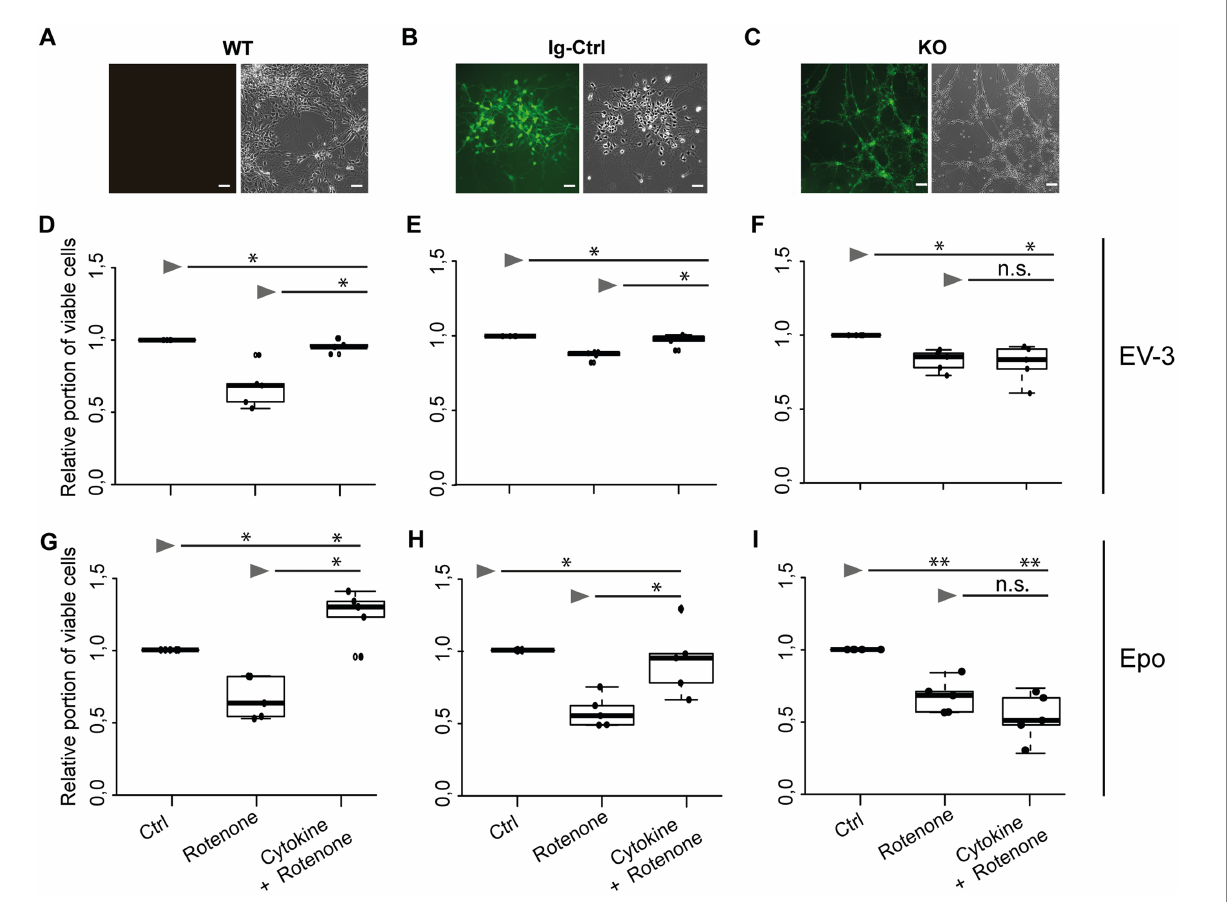
FIGURE 3 EV-3 and Epo induce CRLF3-mediated protection of human iPSC#1-derived neurons. Vertical panels depict data and images from WT (A,D,G) , isogenic controls (Ig-Ctrl) (B,E,H) , and CRLF3-mutated (KO) (C,F,I) iPSC-derived neurons. (A–C) Brightfield and fluorescent images of iPSC-derived neurons. Ig-Ctrl (B) and KO (C) cells display GFP fluorescence, indicating Cas9-GFP fuse transcript. (D–I) Relative survival of iPSC#1-derived neurons. Cells were prepared for FACS analysis by live/dead and ß-III-tubulin staining. (D–F) Data collected for neuron-like cells treated with EV-3. 18 h exposure to 800 nM rotenone reduced the survival of WT (D) , Ig-Ctrl (E) , and KO (F) neurons significantly when normalized and compared to survival in respective untreated control cultures. Rotenone-induced cell death was prevented by EV-3 (41.5 ng/mL) in WT and Ig-Ctrl neurons but not in CRLF3- KO neurons. n = 5 for all. (G–I) Relative survival of iPSC#1-derived neurons treated with Epo. 800 nM rotenone-induced cell death was prevented by 41.5 ng/mL Epo in WT (G) and Ig-Ctrl (H) cells. CRLF3-KO cells were not protected by Epo treatment. n = 5 for all. Data is presented as boxplots showing the median cell survival, upper and lower quartile and whiskers representing 1.5 × interquartile ranges. Single data points are shown as circles within the boxplot. Statistics with pairwise permutation test and Benjamini-Hochberg correction for multiple comparison. Significant differences: n.s, not significant, * p < 0.05, ** p <